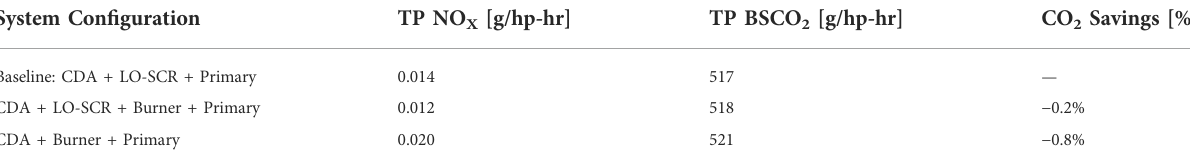
TABLE 3 Composite HD-FTP results for all the aftertreatment con fi